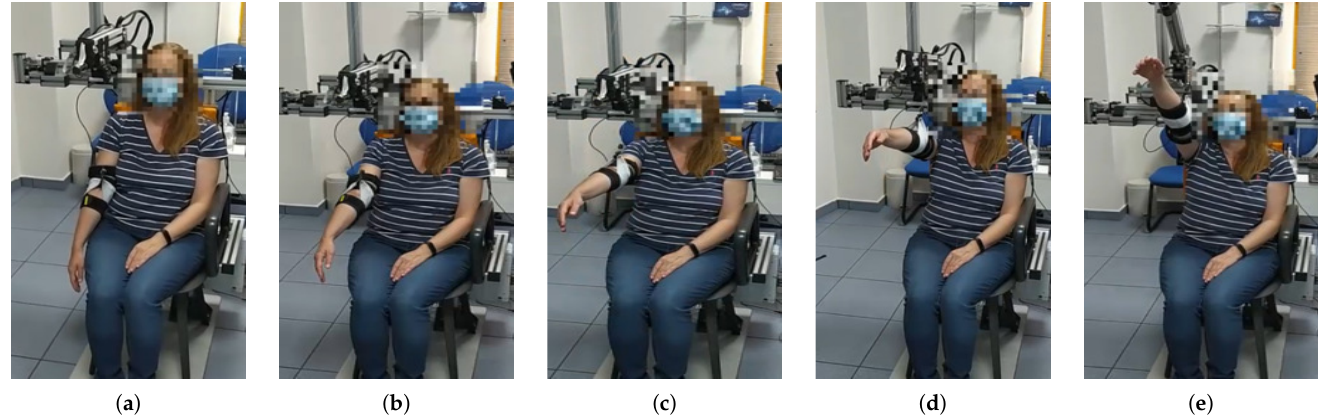
Figure 5. From ( a – e ) a series of frames corresponding to a flexion movement ( θ = 0 ◦ ) are shown. Similarly to the abduction movement, until reaching the 90 degrees arm elevation, the elevation of the arm is uniquely performed by reducing the cable length. In this case, a maximum elevation angle φ of 130 degrees was programmed, according to the patient’s needs.